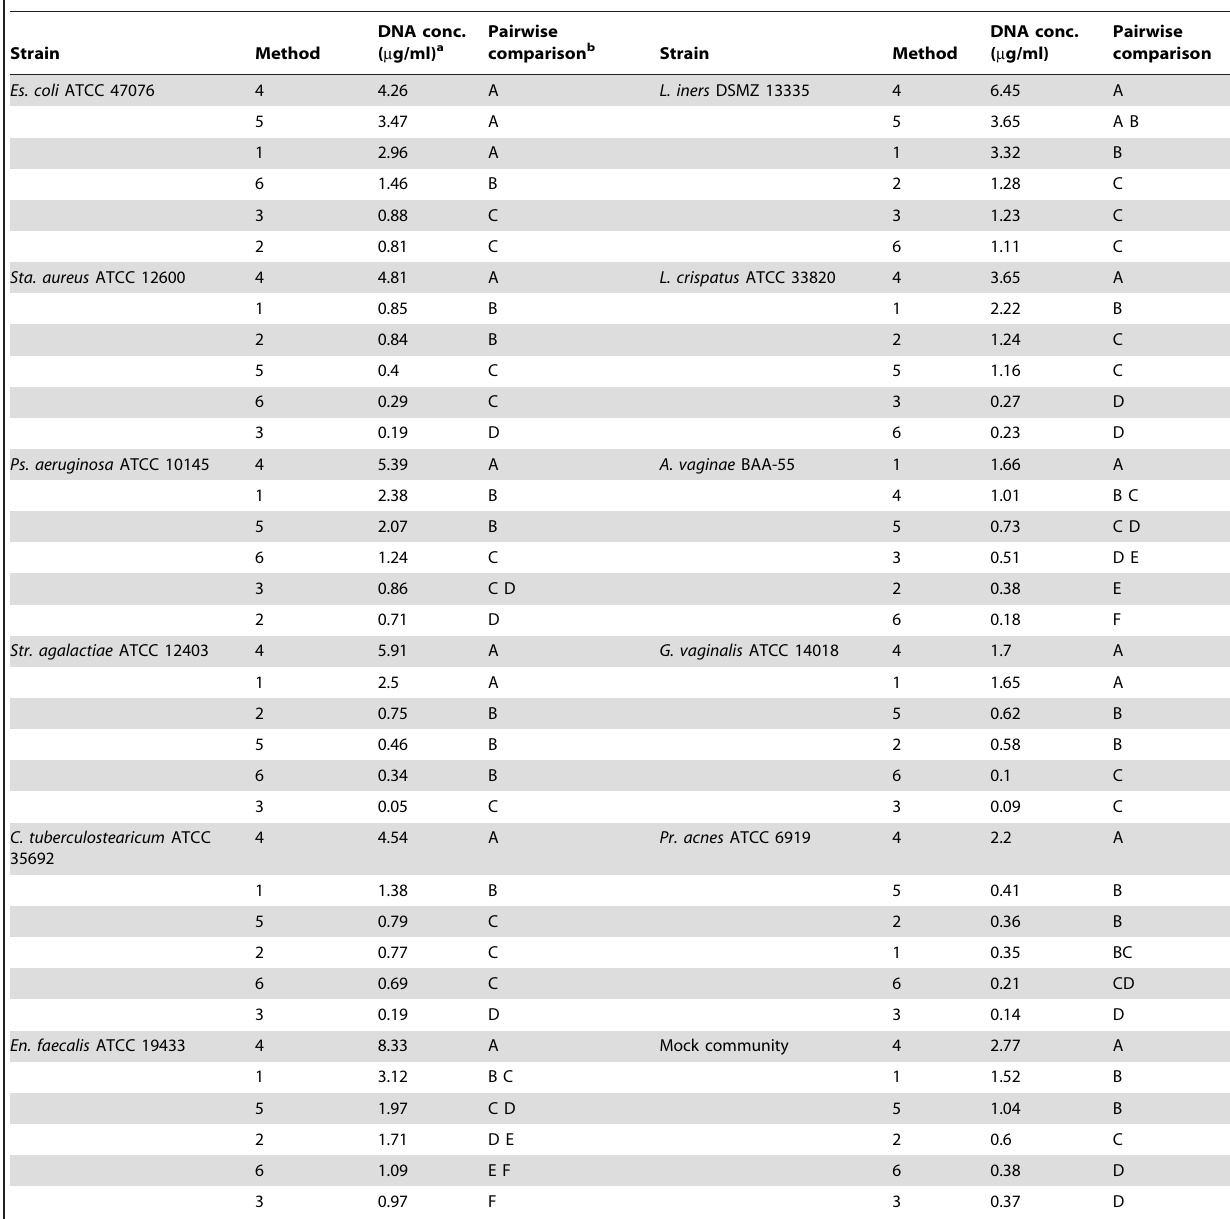
Table 3. Comparison of DNA yields of type strains obtained using six DNA extraction methods.